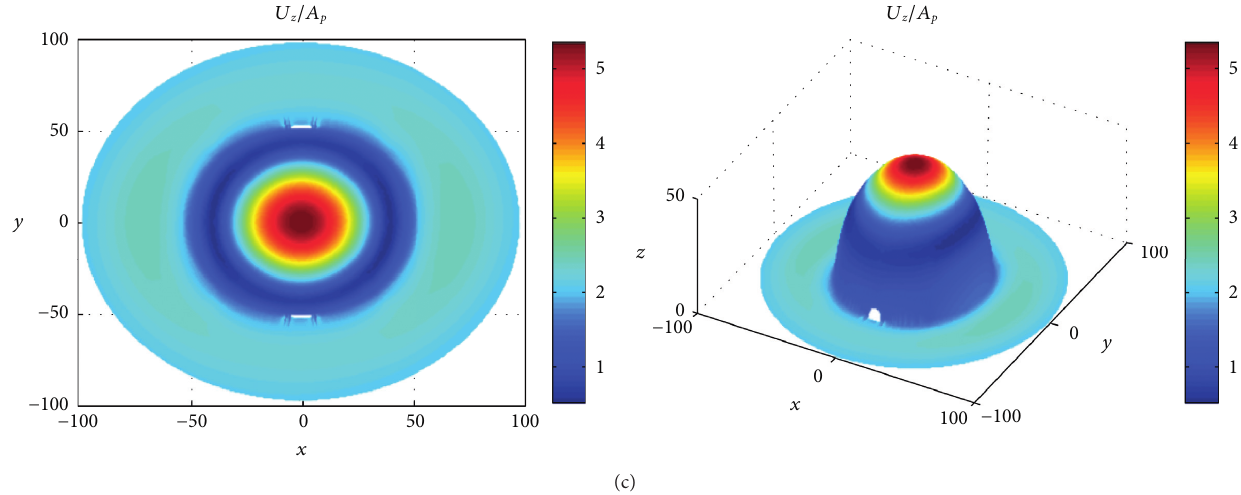
Figure 4: Surface displacement amplitude of the 3D tunnel mountain under the incident P wave ( η � 1 . 0 , α � 0 ° ): (a) surface displacement amplitude in x direction; (b) surface displacement amplitude in y direction; (c) surface displacement amplitude in z